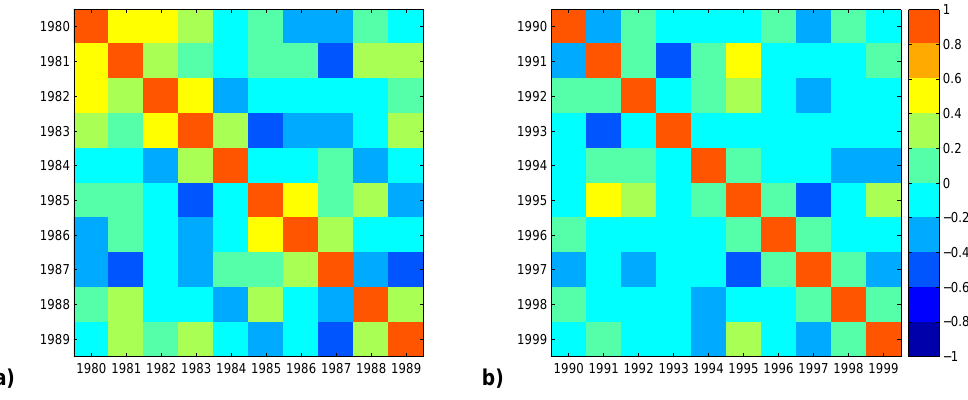
Fig. 4. Uncertainty correlation matrix of global mean NEP for (a) the 1980s and (b) the 1990s.